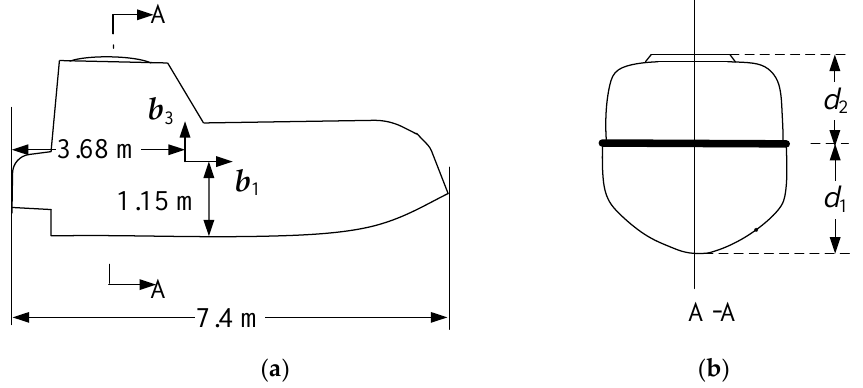
Figure 4. Lifeboat cross section: ( a ) longitudinal section in center plane, ( b ) A‒A cross section.